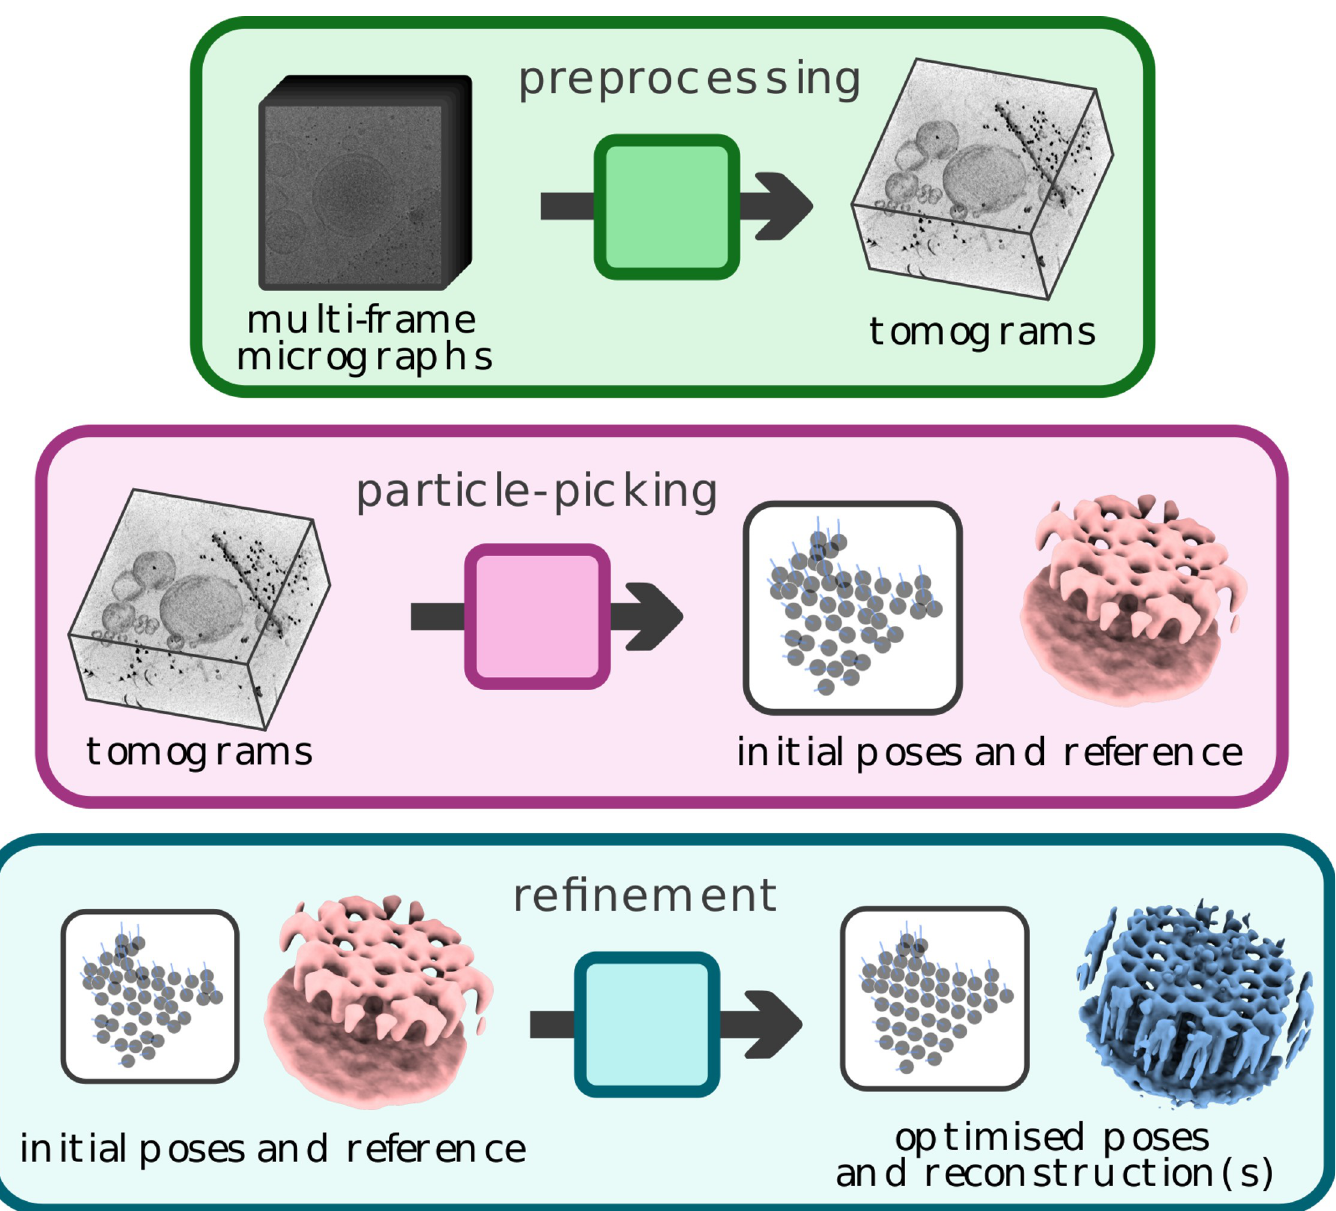
Fig 1. Cryo-ET data processing can be roughly divided into 3 blocks. Preprocessing (top) transforms raw experimental data, usually in the form of multiframe micrographs, into 3D images called tomograms. Particle picking (middle) derives particle position and orientation information from tomograms as well as an initial reference for subsequent refinement. Refinement (bottom) optimises (multiple) 3D reconstructions from input data. cryo AU : Abbreviationlistshavebeencompiledforthoseusedinfigurecaptions : Pleaseverifythatallentriesarecorrect : -ET, cryo-electron tomography.